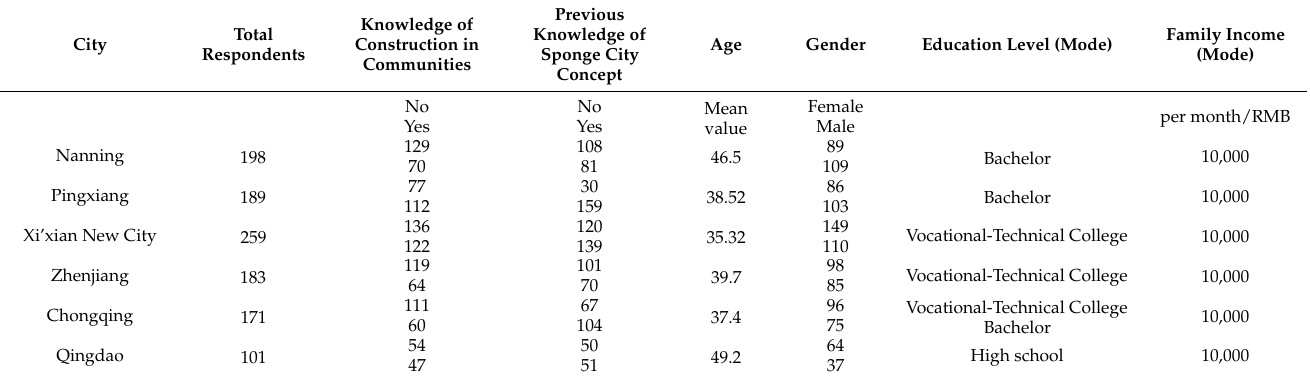
Table 1. Profiles of respondents’ demographic information in each